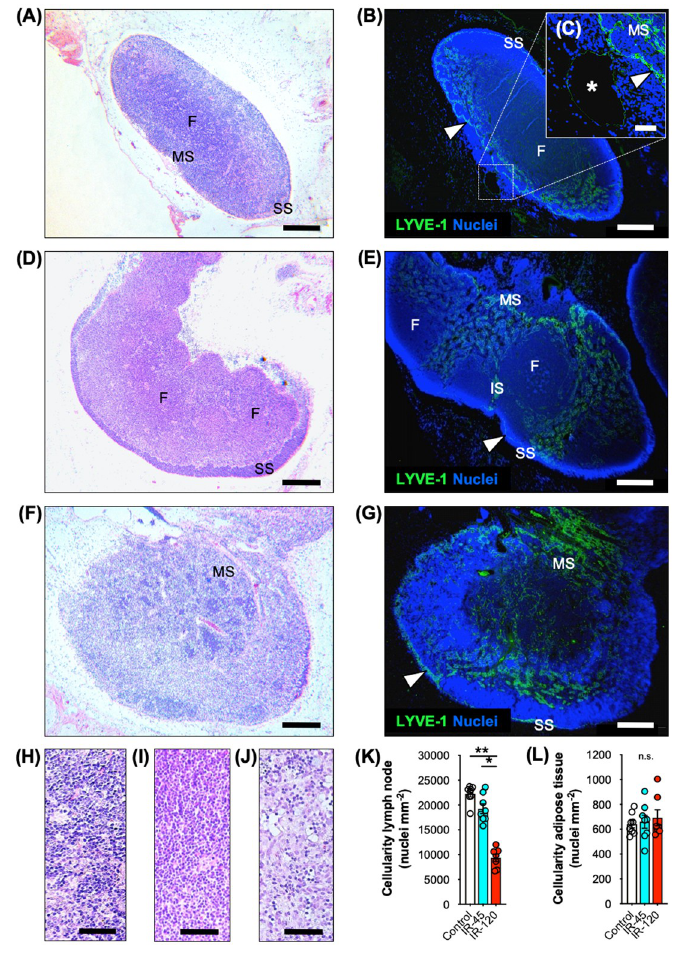
Fig 3. Structural alterations of VLN flaps after IR injury. A-G HE-stained ( A, D and F ) and immunohistochemical ( B, C, E and G ) sections of control ( A-C ), IR-45 ( D and E ) and IR-120 ( F and G ) VLN flaps. SS = subcapsular sinus, IS = intermediate sinus, MS = medullary sinus, F = follicle. Arrowhead = LYVE-1 + cell-lined sinus. C (insert of B ) Asterisk = main efferent lymphatic vessel. H-J HE-stained section of follicles of control ( H ), IR-45 ( I ) and IR-120 ( J ) lymph nodes. K Lymph node cellularity (nuclei mm -2 ). Mean ± SEM, n = 7–8, � P < 0.05, �� P < 0.001. L Adipose tissue cellularity (nuclei mm -2 ). Mean ± SEM, n = 7–8, n.s. = not significant. Scale bars: A, B, D-G = 300 μ m, C = 40 μ m, H-J = 60 μ m. HE = hematoxylin and eosin, LYVE = lymphatic vessel endothelial hyaluronan receptor, VLN = vascularized lymph